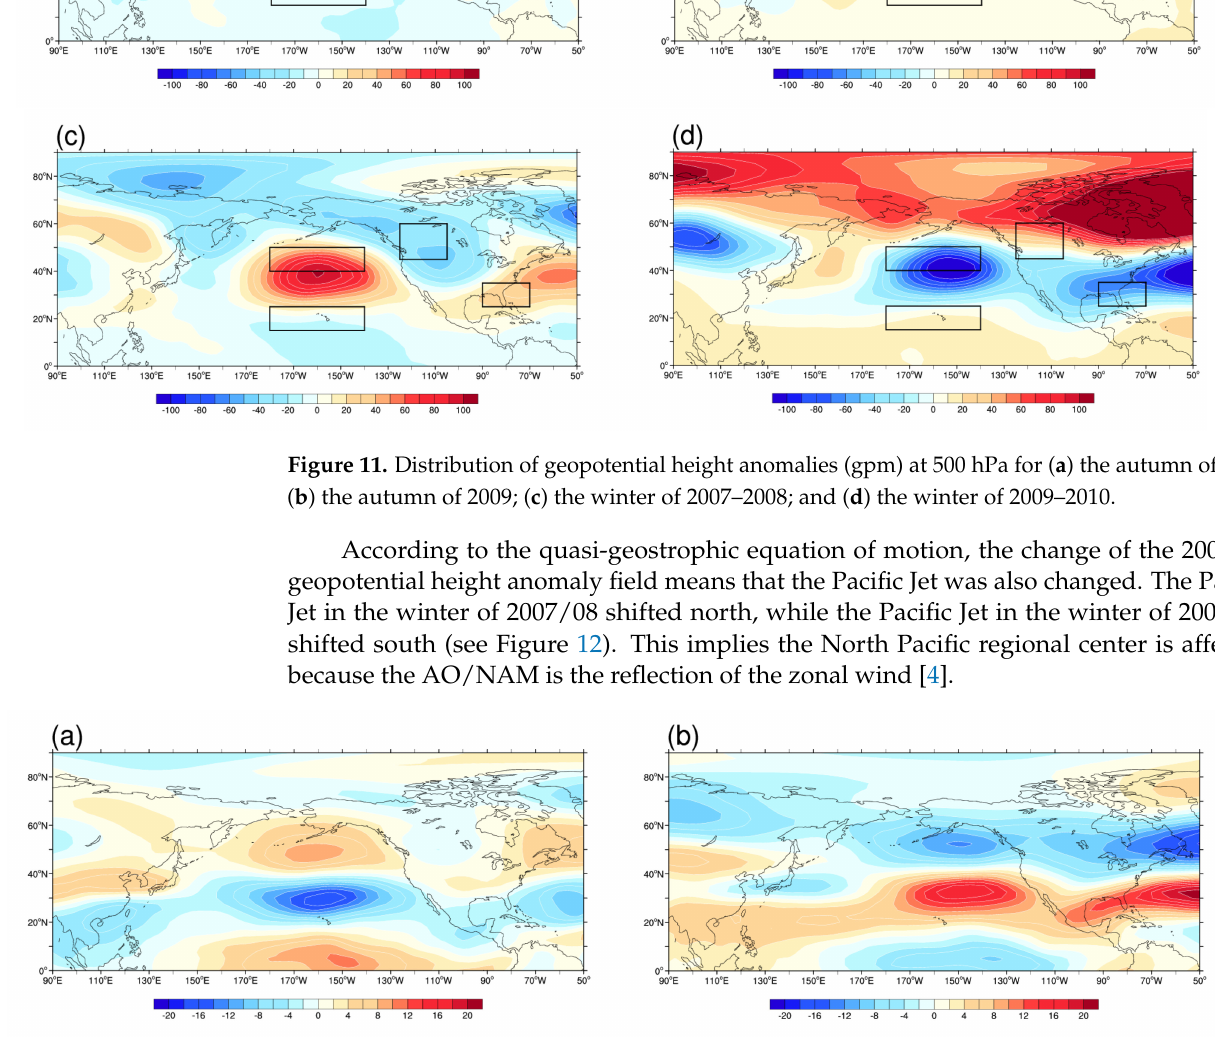
Figure 12. Distribution of zonal wind anomalies (m · s − 1 ) at 200 hPa for ( a ) the winter of 2007–2008 and ( b ) the winter of